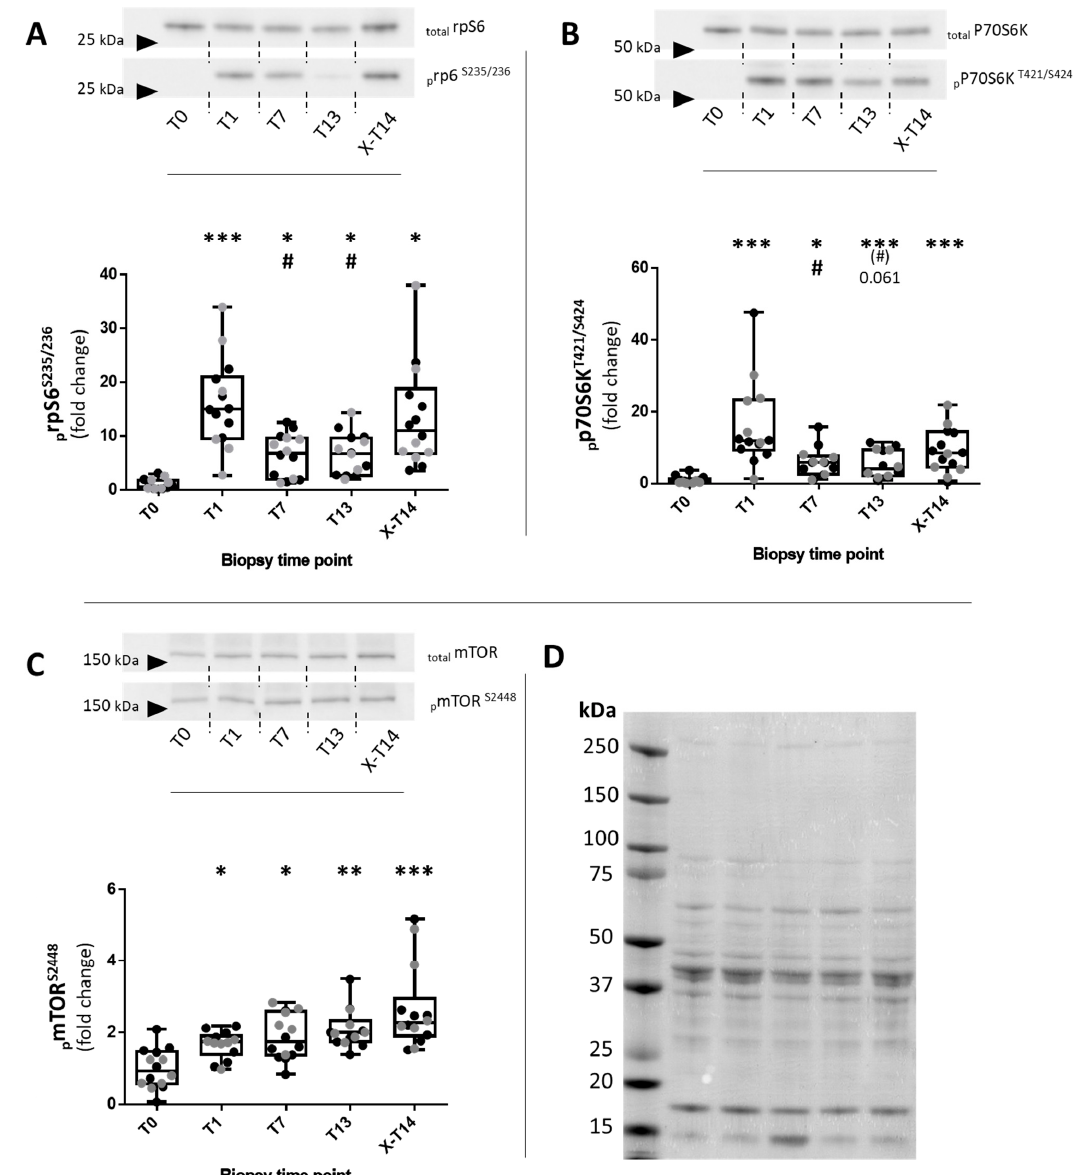
Figure 1. Western blotting analysis of acute responses of phosphorylated and total levels of mTOR, p70S6k, and rpS6 in human skeletal muscle during repeated RE. Regulation of p rpS6 S235/236 ( A ), p p70S6k T421/S424 ( B ), and p mTOR S2448 ( C ) at rest (T0), 45 min after the 1st RE session (T1), after the 7th (T7) and 13th RE sessions (T13), and after 10 days of detraining (X-T14). Upper panel: Representative images of membranes probed for the respective proteins (phospho- and total protein). Lower panel: Box–whisker plots for the individual proteins: upper whisker (max), lower whisker (min), upper box (75th percentile), lower box (25th percentile), and median. p mTOR S2448 , p p70S6k T421/S424 , and p rpS6 S235/236 were normalized to the total protein levels for each time point and individual subject. Normalization to the baseline (T0) was performed by dividing all time points of individual subjects by the total average of T0. Differently colored points represent data from individual subjects from the PR (gray dots) and CO (black dots) groups. * p < 0.05; ** p < 0.01; *** p < 0.001 with respect to T0; # p < 0.05 with respect to T1. ( D ) A Ponceau-S-stained PVDF membrane that was previously subjected to Western blotting and with samples of a representative subject showing all five time